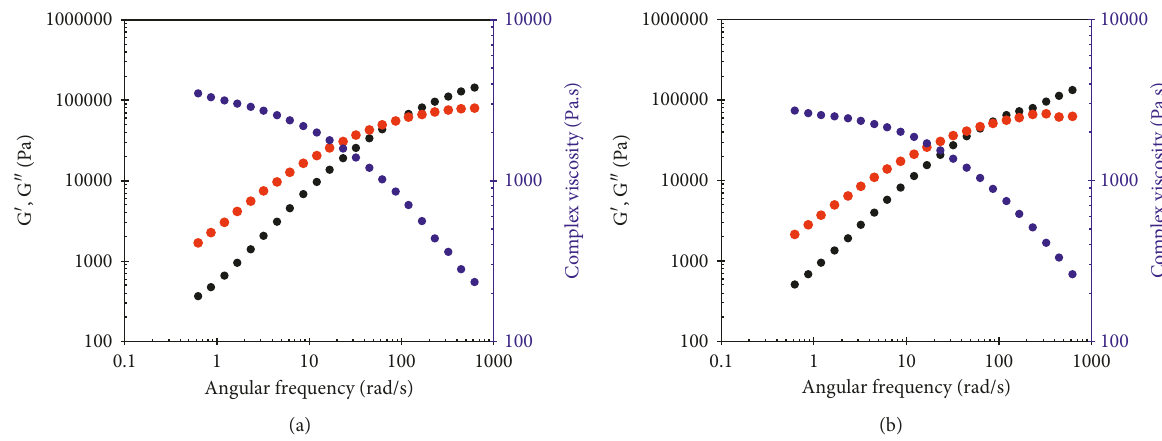
Figure 8: Rheological properties from the dynamic frequency sweep test: (a) ABS filament; (b) ABS/GO composite filament.